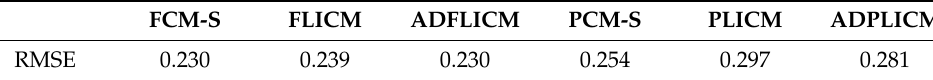
Table 3. Global RMSE values for fuzzy local spatial information classifiers.